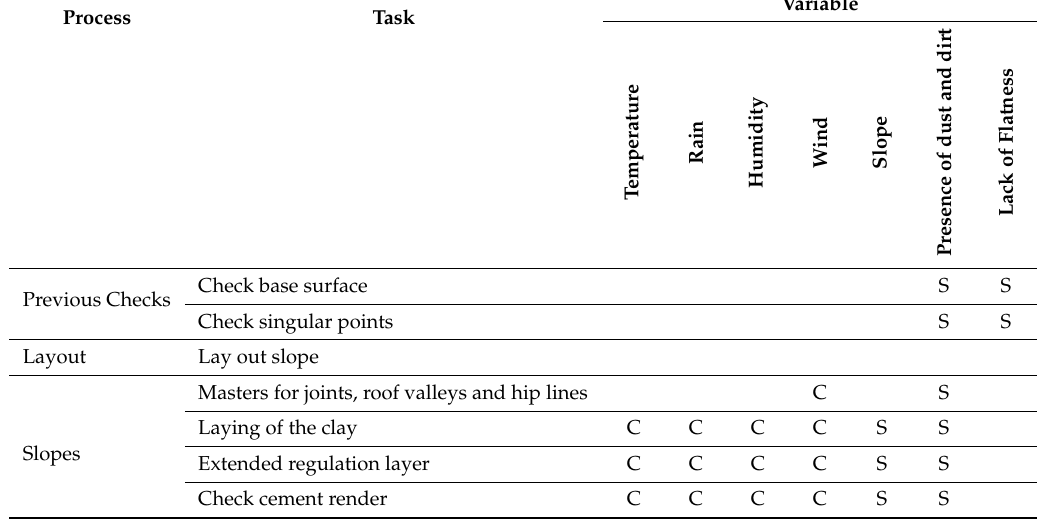
Table 2. Classification of the variables defined in Figure